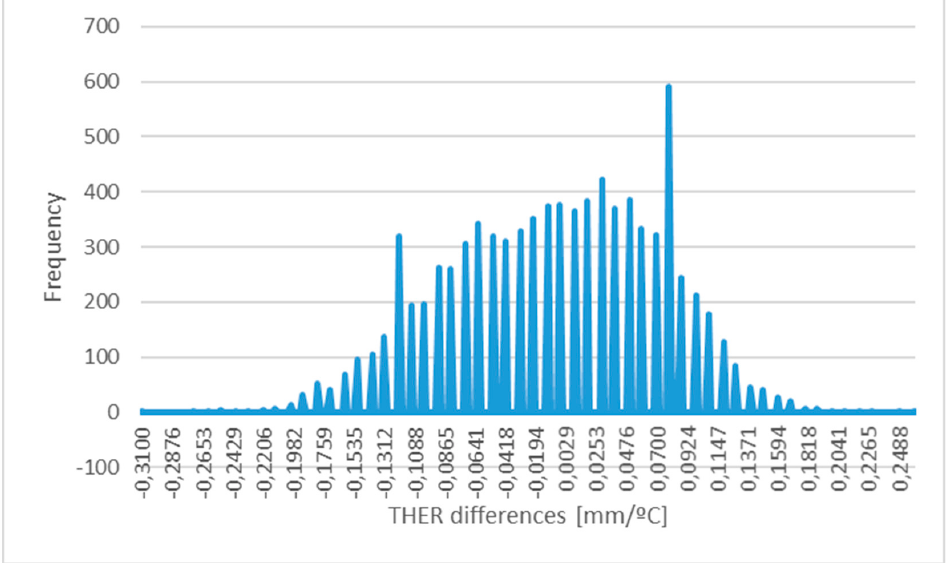
Figure 7. Histogram of the PSI and TomoSAR THER differences.